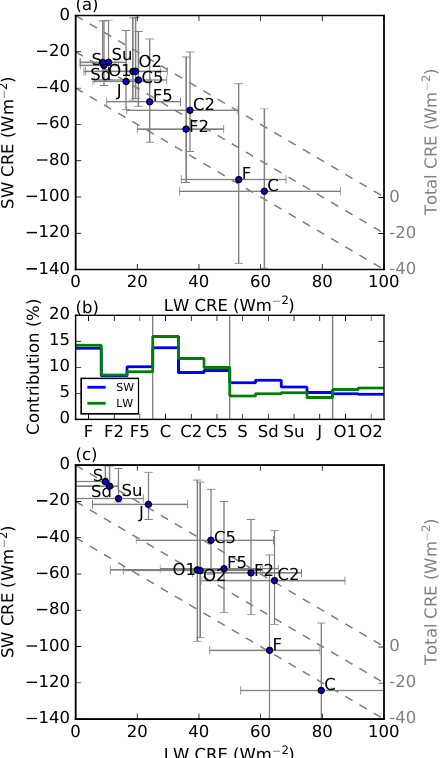
Figure 7. (a) The daily, constant-meteorology mean cloud radiative effect (CRE) in SW and LW for each of the regimes from CERES SYN1deg daily data. A negative value shows a cooling effect and the dashed grey lines are lines to constant net CRE. (b) The con- tribution to the SW and LW global CRE from each regime. (c) As panel (a) but using only pixels where 99% of the MODIS cloud top pressure retrievals are less than 550hPa. The error bars show the 25 and 75% quantiles for each